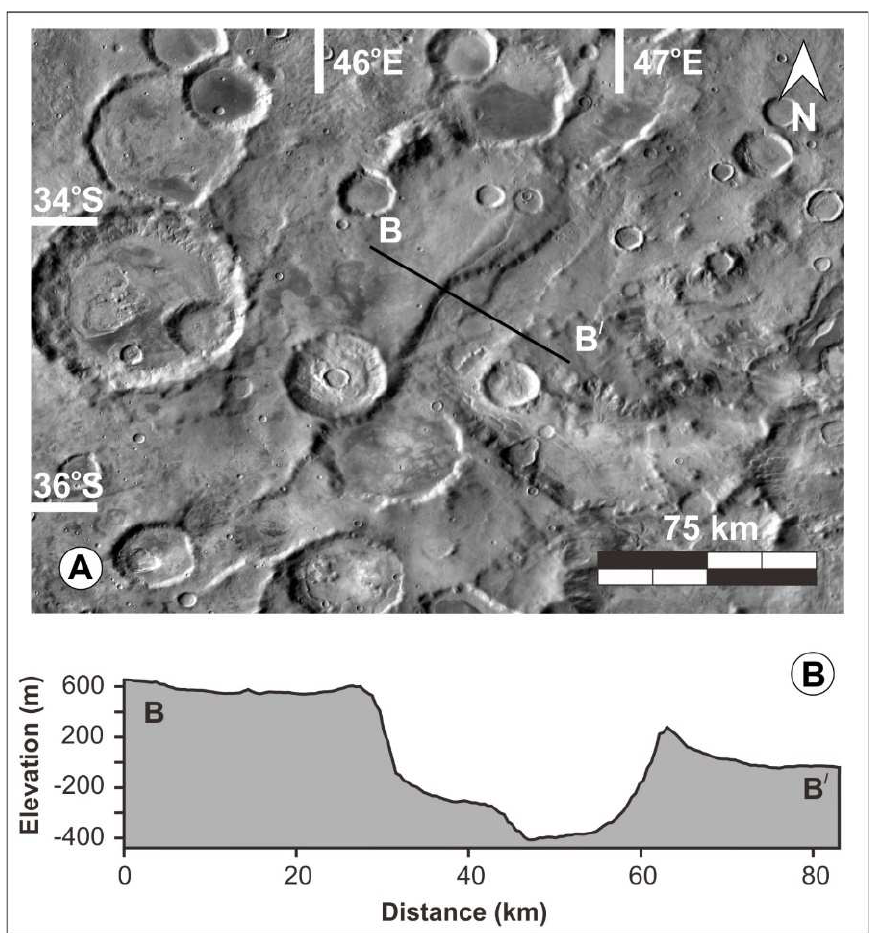
(b) Western Hellas (WH), and (c) North-western Hellas (NWH). The extensional structures of the CH region are in close proximity to the Hellas basin (Figure 2A), most common in the western boundaries, and extend to the northwestern and northern margins. The extensional zone from this set of structures is defined with a series of concentric normal faults dipping towards the Hellas basin, and grabens are tilted basinward (Figure 2B) (set 1 graben on Figure 2: [25]). The extracted profile sections (Figure 2B) suggest that the graben shoulder away from the basin is always at a higher elevation than the shoulder nearer to the basin. The average widths of the grabens are ~35 km with a maximum arc length of 200 km [25]. On the other hand, WH and NWH extensional structures do not show any trend to follow the curvature of the Hellas basin rim and are at a high angle to it. In contrast to the CH extensional structures, the elevation profiles of the WH and NWH grabens rule out the possibility of shoulder elevation offsets in the graben bounding normal faults, and tilt in the graben floor is also missing. The WH grabens are the widest (maximum width > 100 km) and lengthiest (maximum length of 1200 km) among all other sets of extensional structures. WH extensional structures generally trend in the NNE-SSW direction (Figure 3A–C). In the case of NWH extensional structures (Figure 4A–C), they extend ~1500 km, with an ENE-WSW trend, and the average graben width is ~30 km. The maximum width of the WH and the NWH extension zones are 700 and 150 km, respectively.